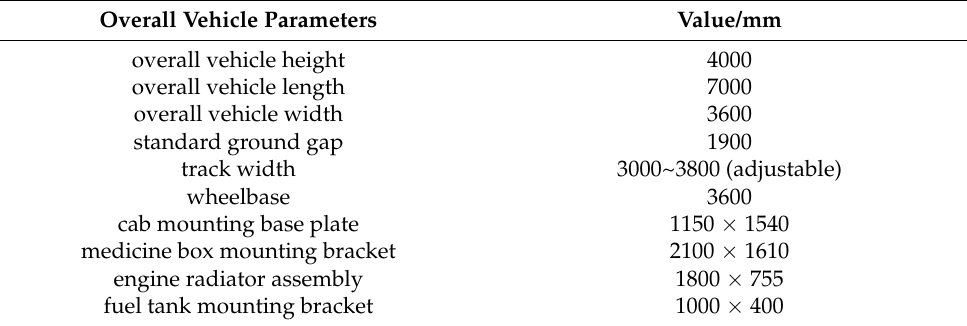
Table 1. Spraying machine structure parameters and installation dimensions.